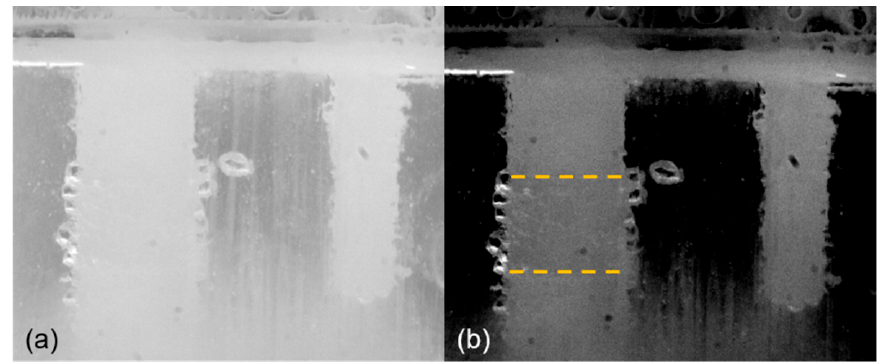
Figure 6. The image ( a ) before and ( b ) after image processing in PFV4 (Photron Fastcam Viewer 4). The image shows an example of using the vertical anode design. The yellow dashed lines indicate the border between the carbon and boron nitride material. The stainless steel rod is shown on the right in the image. The image was taken during electrolysis at a constant current density of 0.25 A cm − 2 .